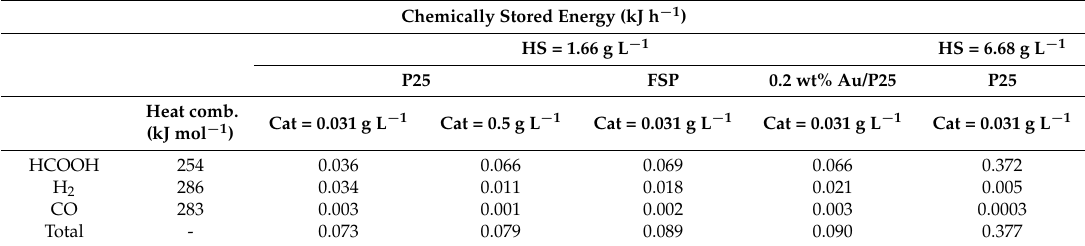
Table 2. Amount of stored energy (kJ h − 1 ) in the form of different reaction products.